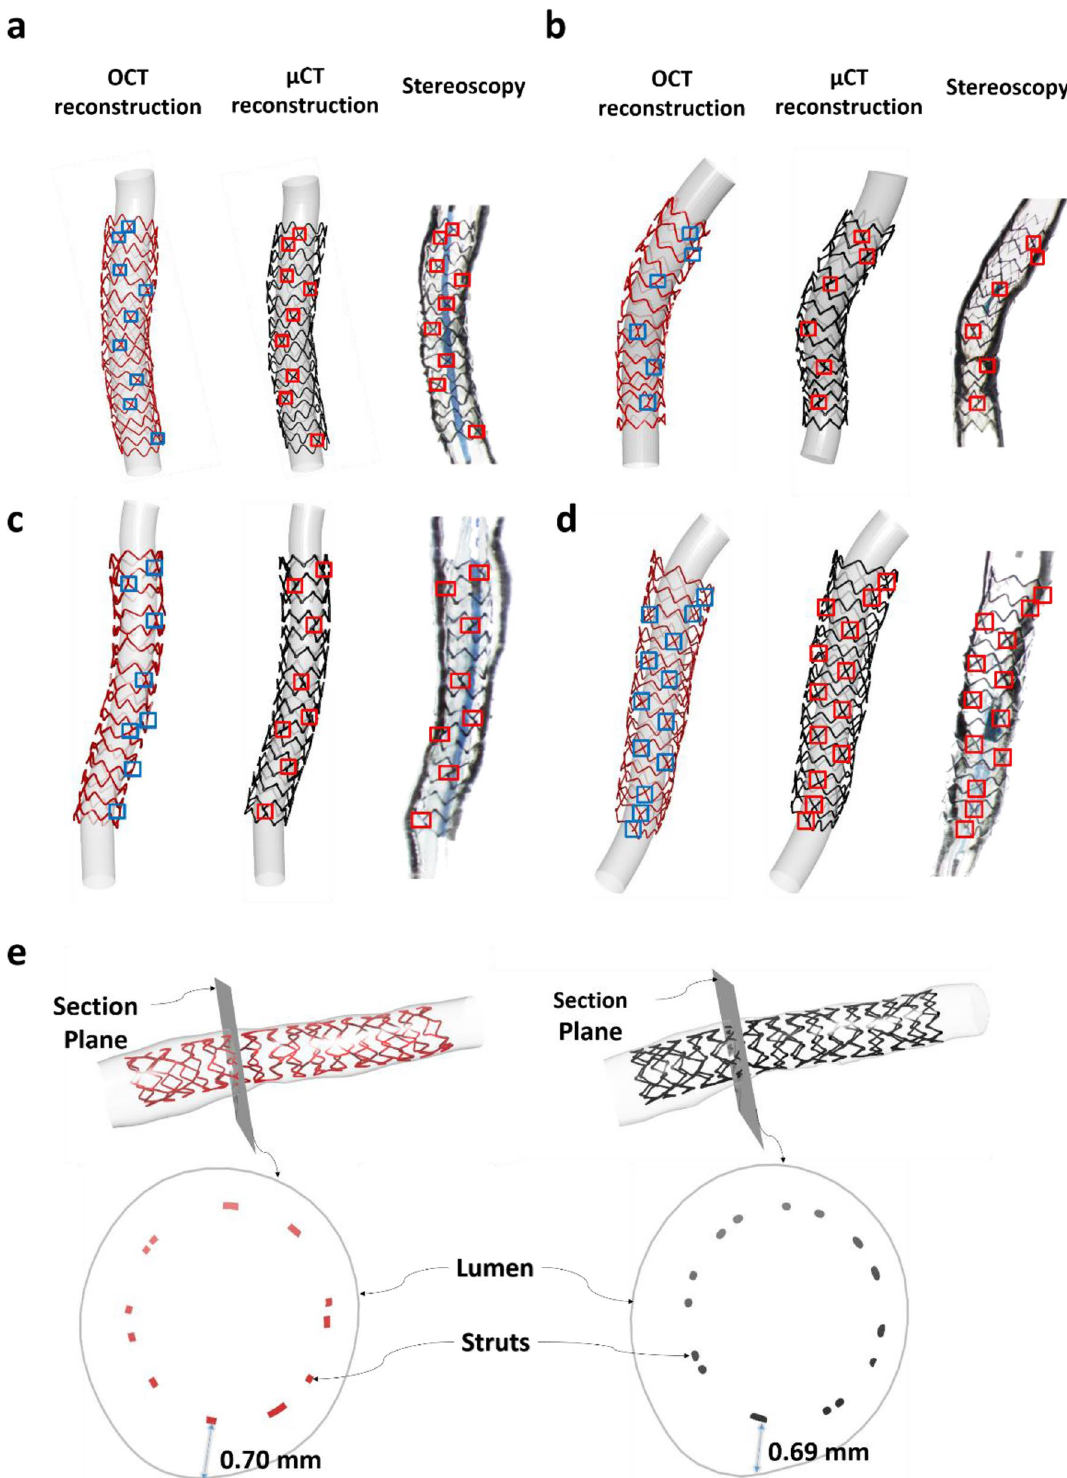
Figure 4. Qualitative experimental validation of stent reconstruction method against μCT and stereoscopic imaging. (a–d) Note the agreement in the link position (blue boxes in OCT-stent reconstructions and red boxes in μCT-stent reconstruction and stereoscopy). In OCT and μCT-based reconstructed models, a tube was inserted for better visualization, whereas in stereoscopy images, a small balloon was inflated in very low pressures for better visualization, (e) Malapposed struts in OCT-stent reconstruction (red stent) at the same location and magnitude compared to μCT-stent reconstruction (black